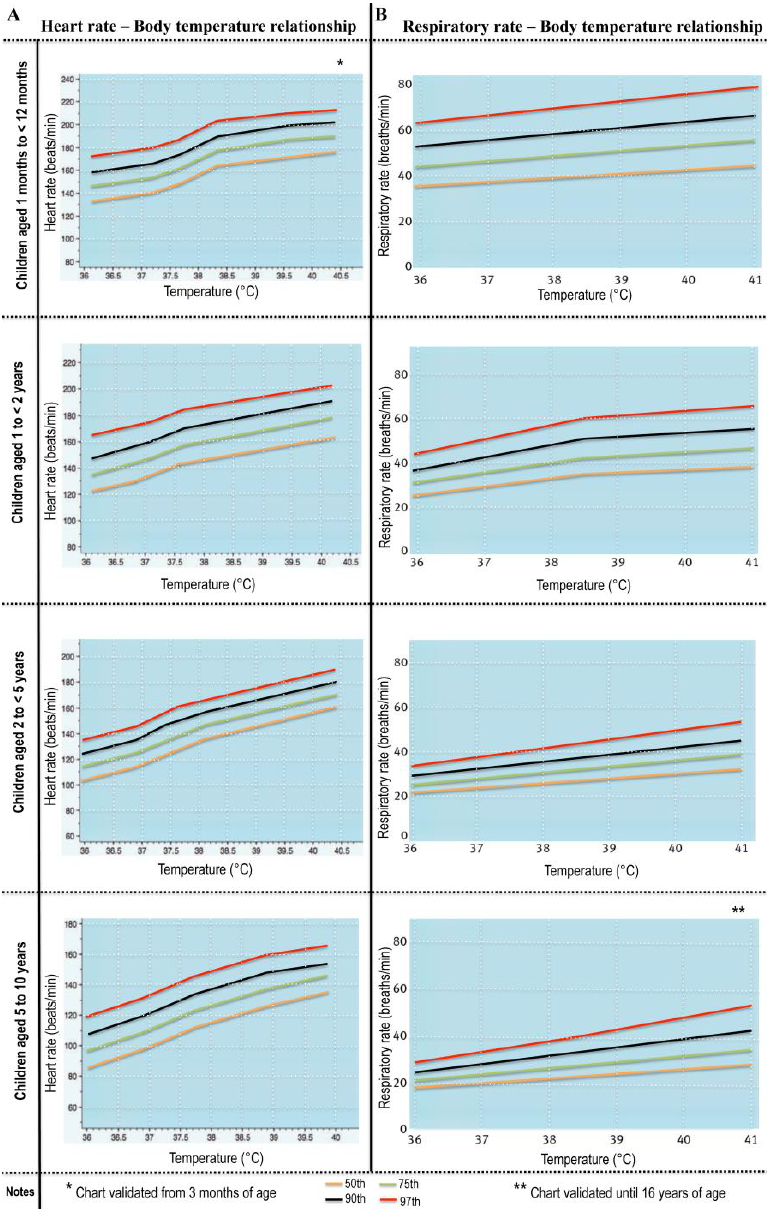
Figure 1. Age-specific temperature-related heart and respiratory rate centile charts (modified from references [46,47] by permission from BMJ Publishing Group Limited).